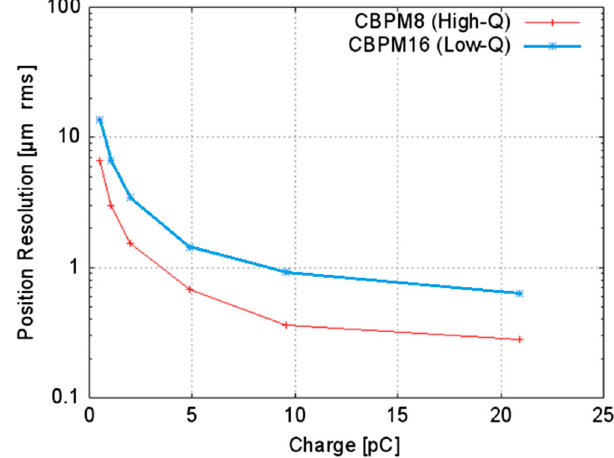
FIG. 9. Absolute single-bunch position resolution as a function of the bunch